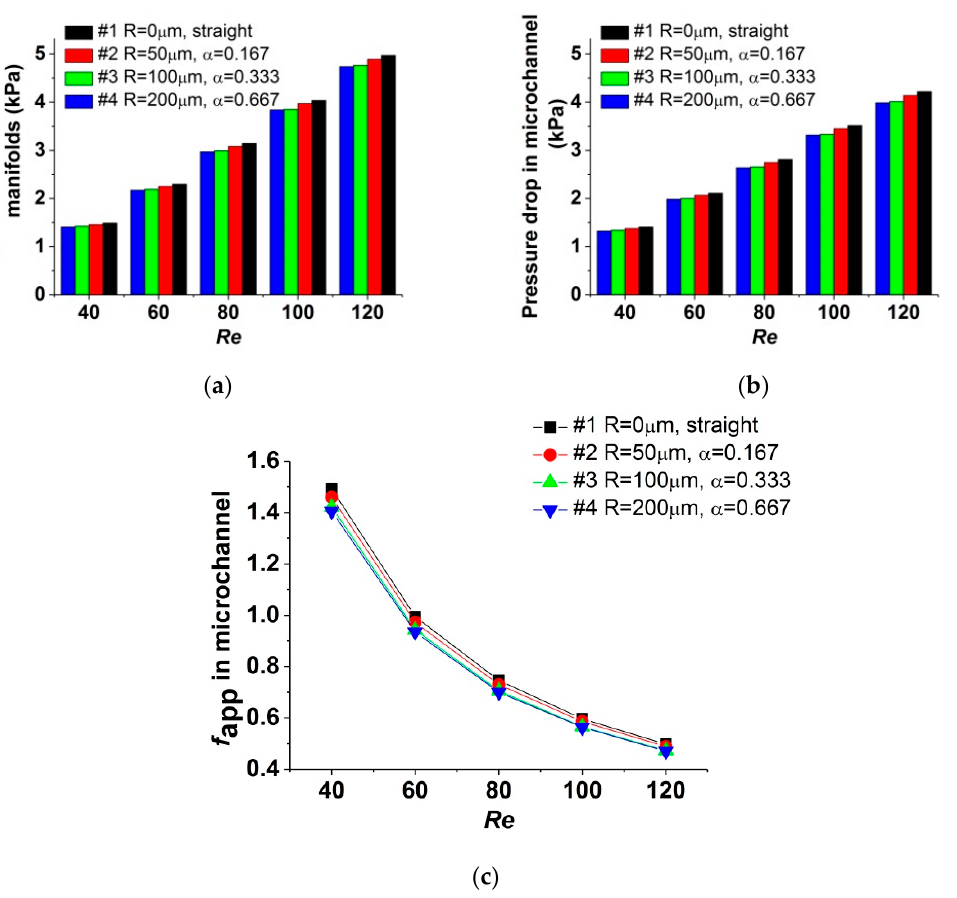
Figure 6. Influence of α on the pressure-drop characteristics when the test sections are unheated. ( a ) Total pressure drop between manifolds; ( b ) pressure drop in microchannel; ( c ) fapp in